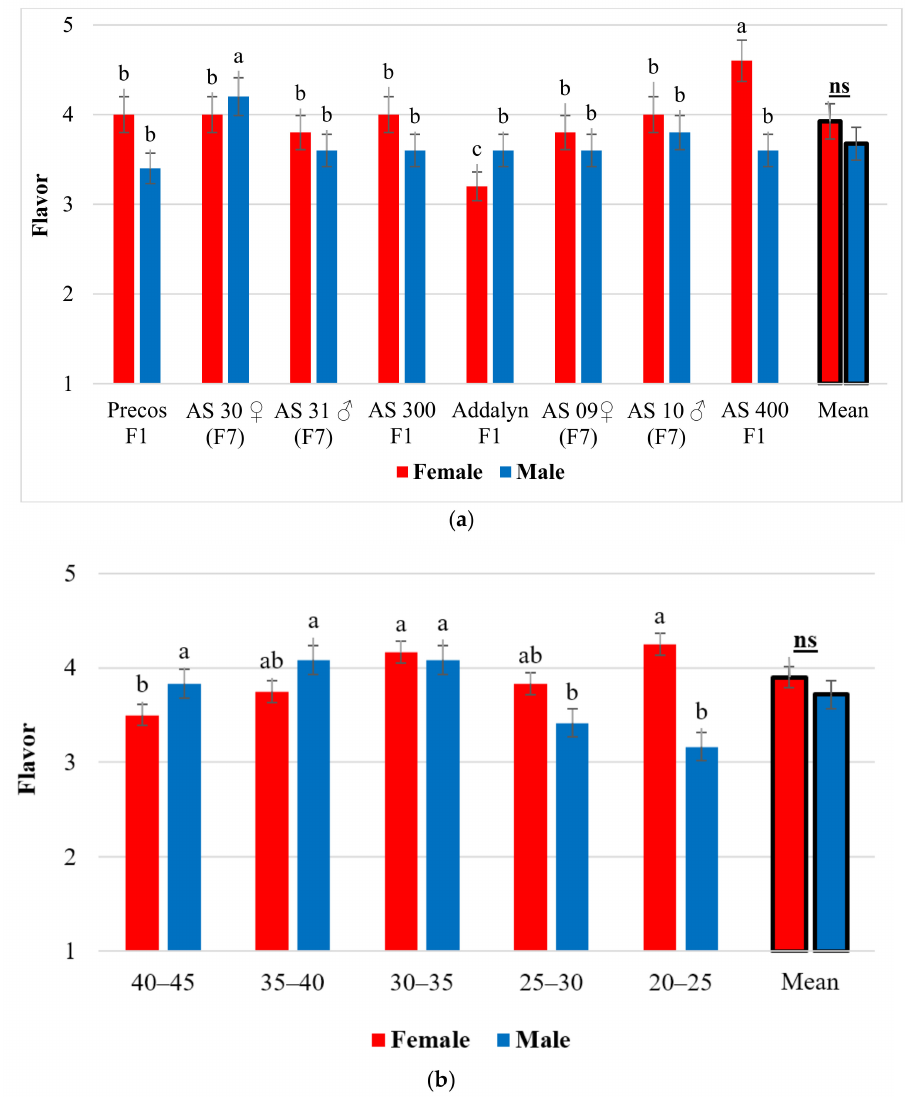
Figure 2. Results obtained for tomatoes flavor on a notes scale of 1–5 (1 = weak; 5 = very good): ( a ) Female and male score, depending on genotype; ( b ) Female and male score, depending on the age groups. The notes are expressed as mean ± SD. Any means in the columns followed by the same letter are not significantly different (Duncan test, α < 0.05). On the latest columns, the average values by types of tasters (women-men) were compared using t -test (Student), α <